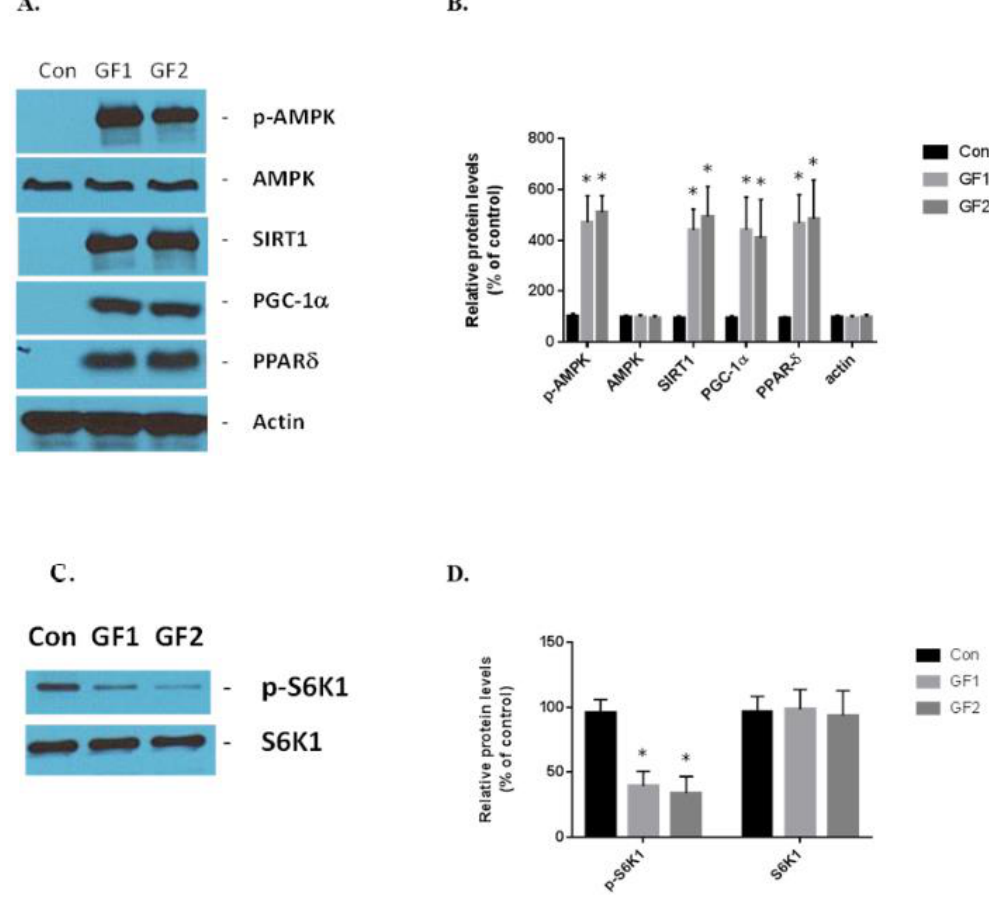
Figure 4. The effect of GF diets on the exercise signaling pathways and autophagy. ( A ) The protein expression of exercise-associated markers, such as p-AMPK, AMPK, SIRT1, PGC-1 α and PPAR δ , was evaluated by Western blot analysis. ( B ) The protein expression levels in ( A ) were plotted for statistical analysis. ( C ) Mice that were fed control or GF diets were evaluated for p-S6K1 and S6K1 activity. ( D ) Evaluation of data from ( C ). The results are expressed as mean ± SD ( n = 10 per group), * p < 0.01 compared to the control group.